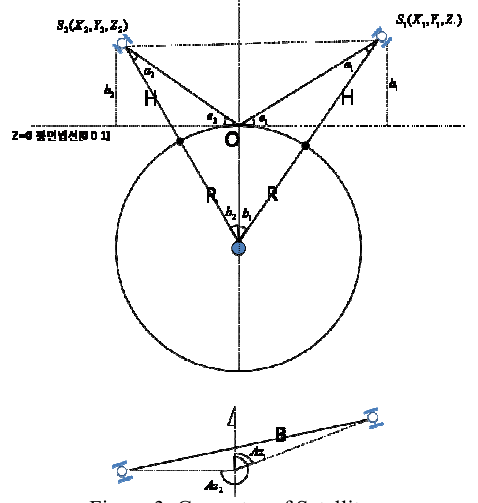
Figure 3. Geometry of Satellites